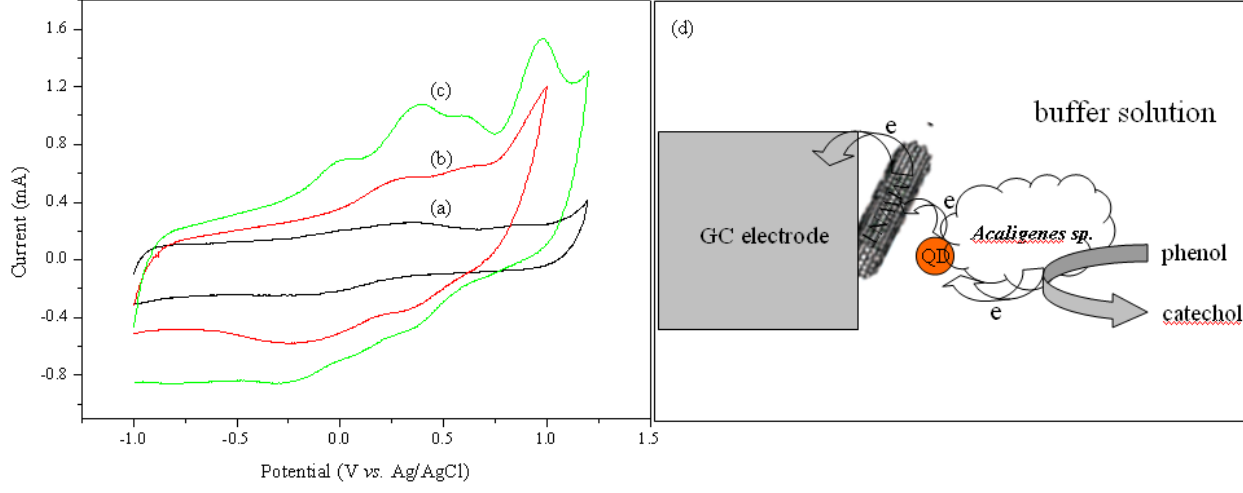
Figure 3. Cyclic voltammogram of microbial biosensor based on PVBA-MWNTs (a) , CdS-MWNT (b) , Cu S-MWNT (c) for 3.0 mM phenol in 0.1 M phosphate buffer solution 2 (pH = 7.0), and possible mechanism of electron transfer in an electrocatalytic process (d)